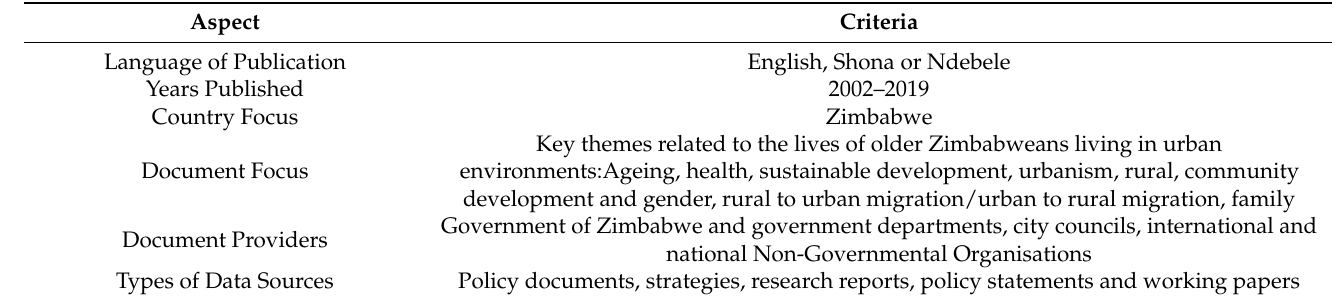
Table 1. Inclusion criteria for reviewed